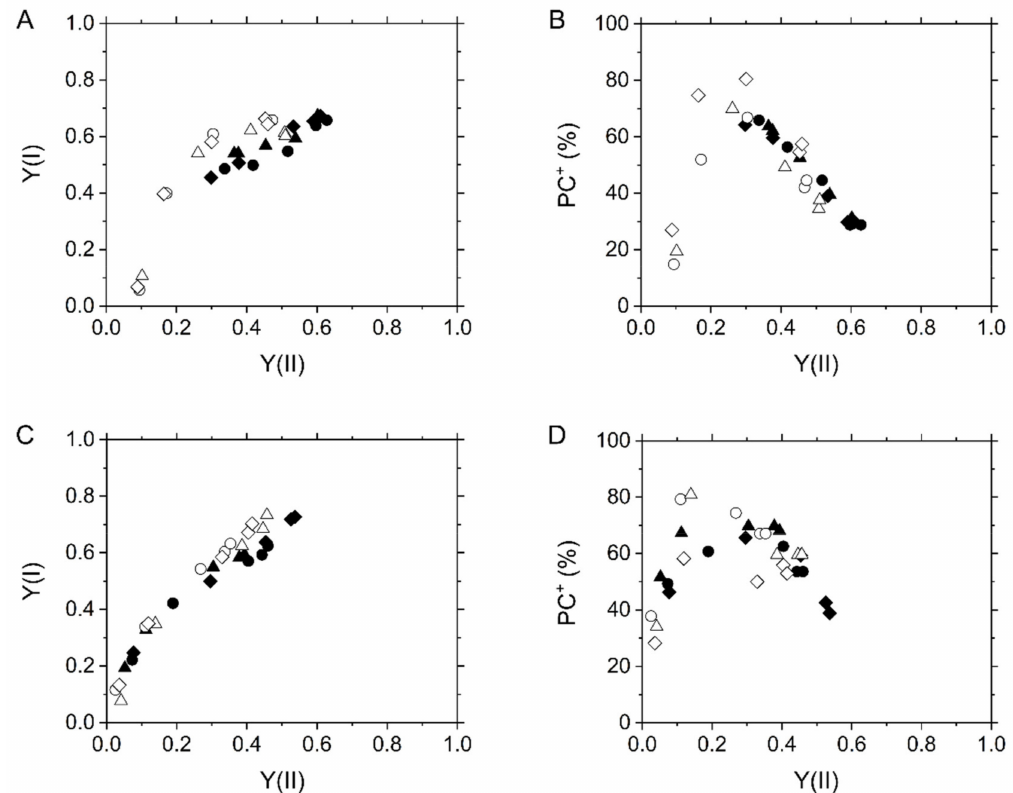
Figure 8. Relationships of effective quantum yield of PSI, Y(I) ( A , C ), and plastocyanin (PC) oxidation ( B , D ) with effective quantum yield of PSII, Y(II), at various intercellular CO 2 partial pressures in the C 3 plant mustard ( A , B ) and the C 4 plant maize ( C , D ). Experiments were conducted independently three times as shown in different symbols (biological replicates) at 21 kPa (closed symbols) and 1 kPa O 2 (open